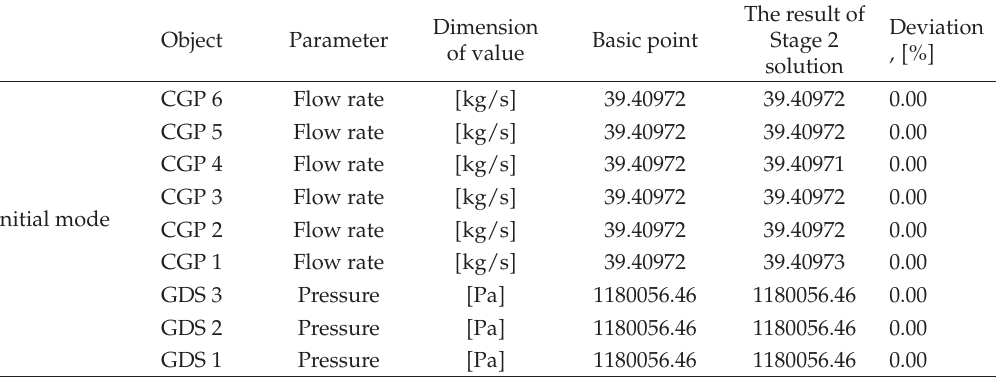
Table 9: Starting point of Stage 3 of the test